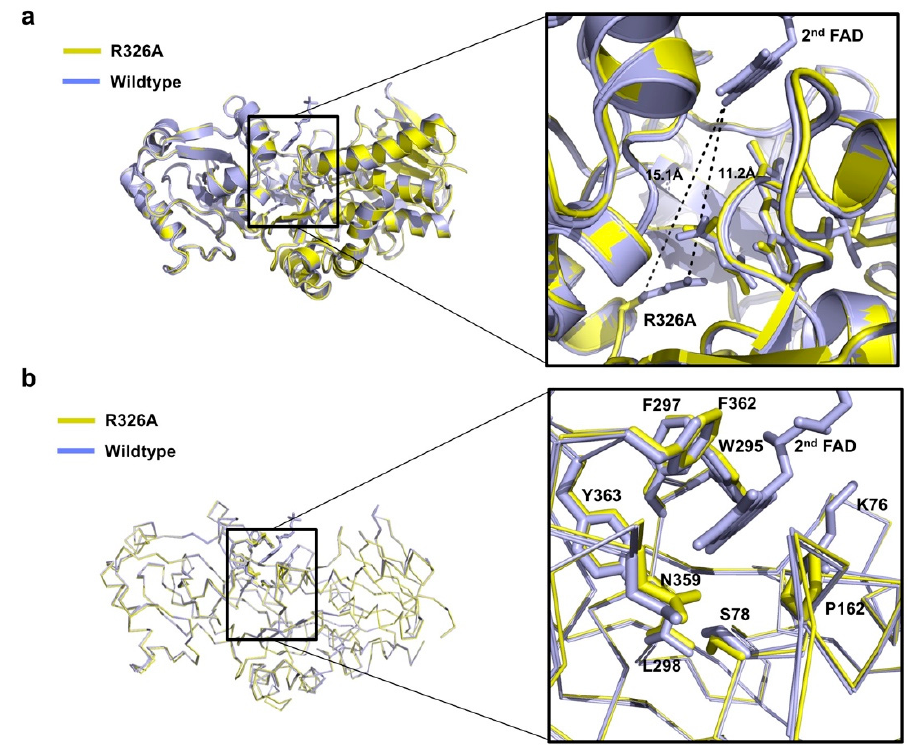
Figure 3. Details of the 2nd FAD binding site of Osm1 R326A: ( a ) Position of R326A and 2nd FAD with distances indicated; ( b ) structural comparison of the 2nd FAD binding site of Osm1 R326A with that of the wild-type.